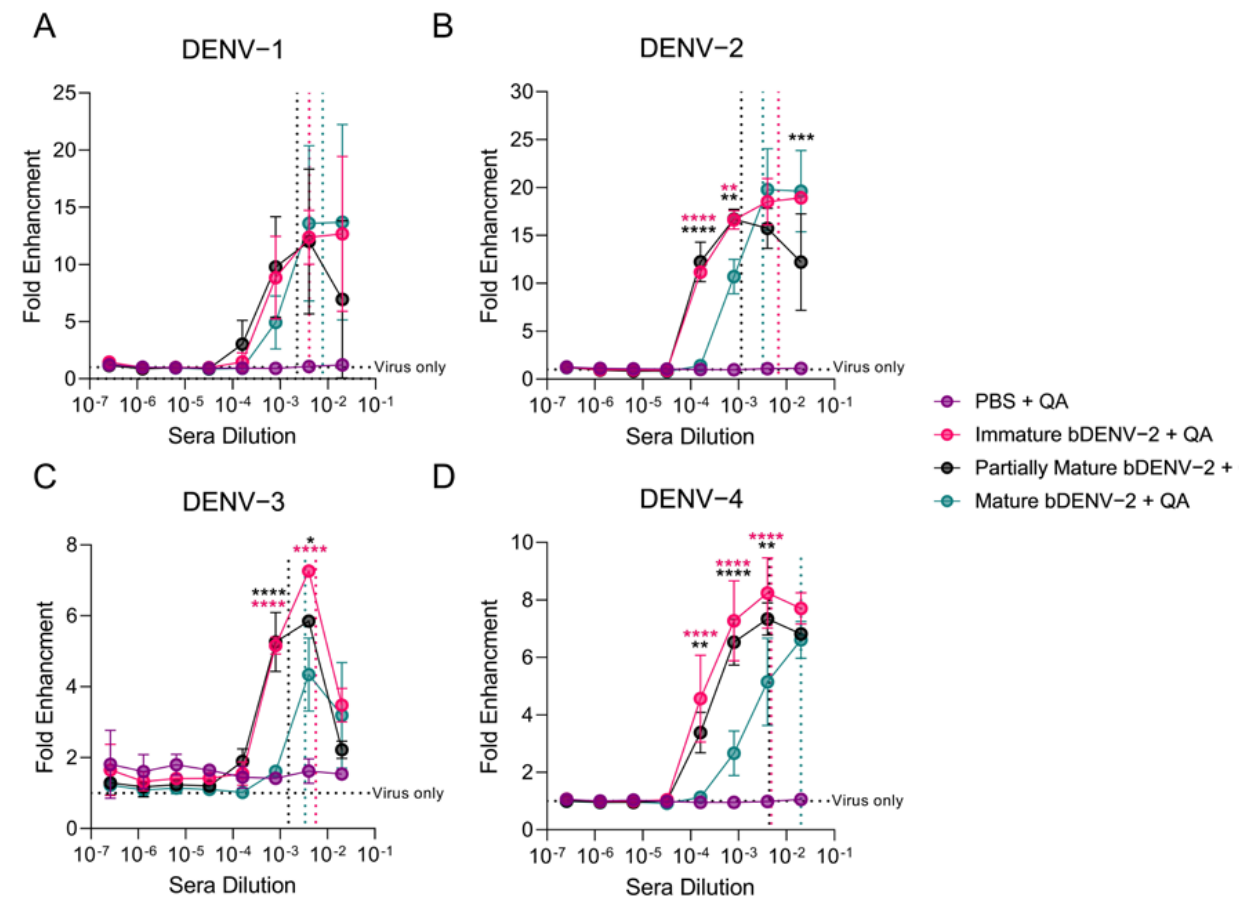
Figure 4. ADE of DENV 1–4 by AG129 immune sera. Fold enhancement of infection by AG129 immune sera in K562 cells relative to virus only control of DENV-1 ( A ), DENV-2 ( B ), DENV-3, ( C ), and DENV-4 ( D ), as determined by sNS1 capture ELISA. Dotted vertical lines depict the mean PRNT 50 values of AG129 immune sera to each virus. Each data point represents the mean of two independent replicates ± SD. Significance was determined using an ordinary one-way ANOVA with Tukey’s multiple comparisons test on GraphPad Prism 9.0. **** p < 0.0001, *** p < 0.0002, ** p ≤ 0.002, * p ≤ 0.03, ns p ≥